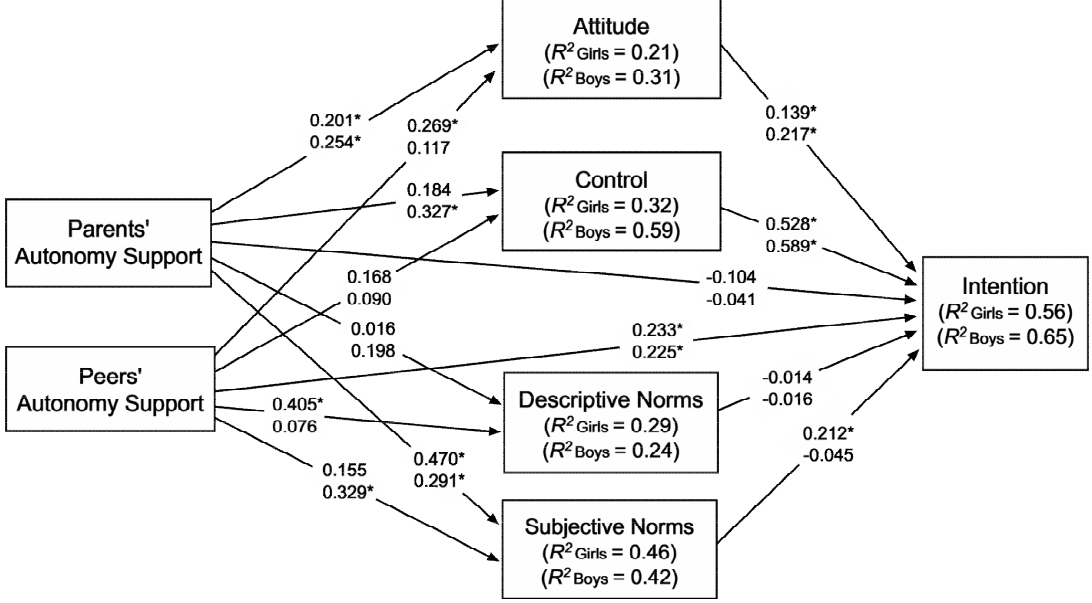
Figure 2. Direct effects and explained variance in the mediation model. Unstandardized regression coefficients shown were obtained by applying 20,000 bootstrapping iterations. The values in the top (bottom) row show the estimates for girls (boys). For the sake of clarity, the following values have not been included in the graphical representation: (a) the effects of the control variable (i.e., past exercise behaviour in the last six months), and (b) the covariance terms between parents’ and peers’ autonomy support. * Denotes a statistically significant regression coefficient (i.e., the 95% CI does not contain the zero value).